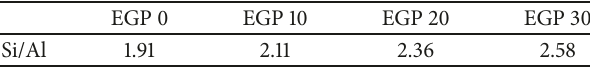
Figure 5: Partial enlarged detail of a and b. Table4:Silicon-aluminumratioofgeopolymerswithdifferentresin